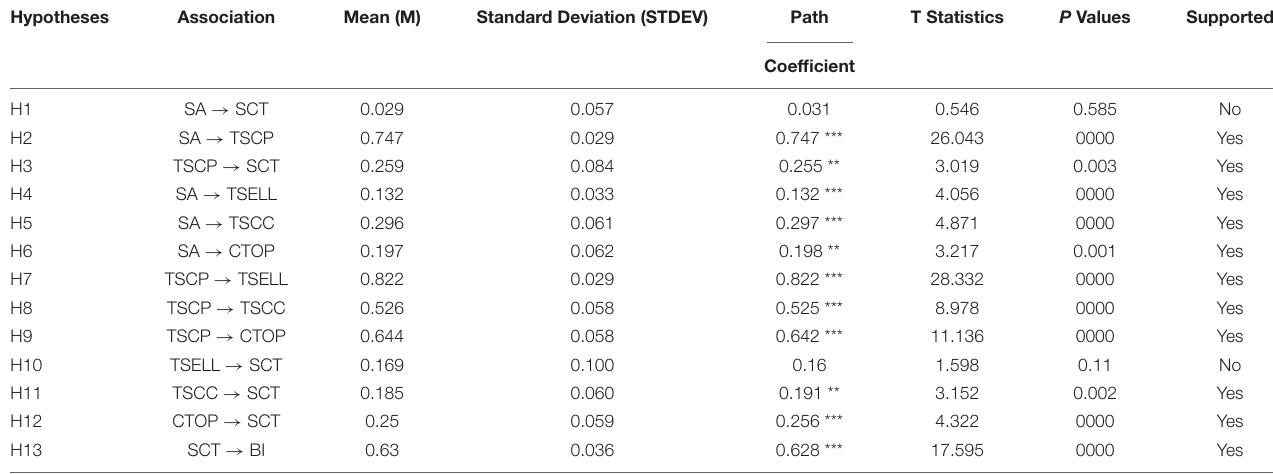
FIGURE 4 | High constructs results. TABLE 6 | Hypotheses testing